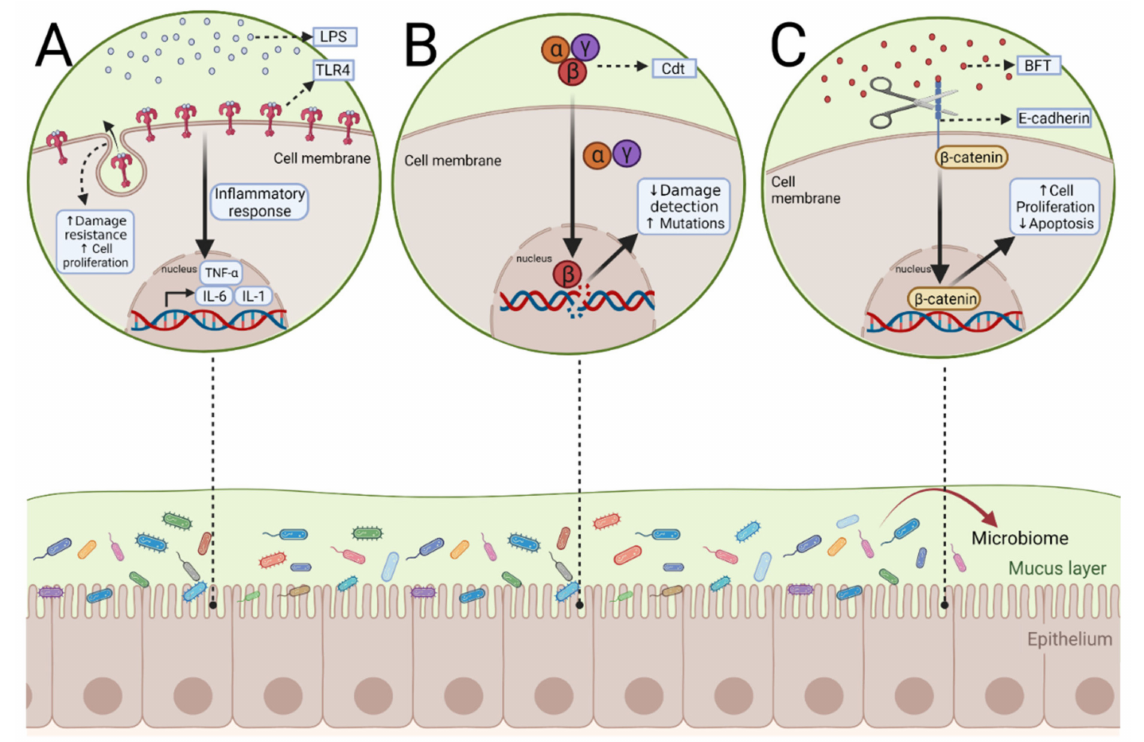
Figure 3. Potential mechanisms of microbial activation of pathways leading to colitis-associated colon cancer. ( A ) Lipopolysaccharides (LPS) produced by gram-negative bacteria such as F. nucleatum and Salmonella bind to the receptor TLR4. This leads to the transcription of inflammatory cytokines such as tumor necrosis factor (TNF- α ), interleukin-6 (IL-6), IL-1, and type I interferons. During IBD, TLR4 is upregulated and may cause CAC, due to its proliferation-promoting ability. ( B ) In this scenario, the heterotrimer produced by pathogenic gram-negative bacteria, Cytolethal distending toxin (Cdt), can directly induce CAC. CdtB is the only active subunit and can make DNA double- stranded breaks or single-stranded breaks. Chronic exposure to CdtB can reduce the damage response system and increase the chance of mutations. ( C ) When Bacteroides fragilis toxin (BFT) produced by Bacteroides fragilis binds to E-cadherin, it can cause cleavage of the protein receptor, B-catenin, normally bound E-cadherin dissociates and becomes a transcription factor for cell proliferation. BFT also delays the apoptosis of intestinal epithelial